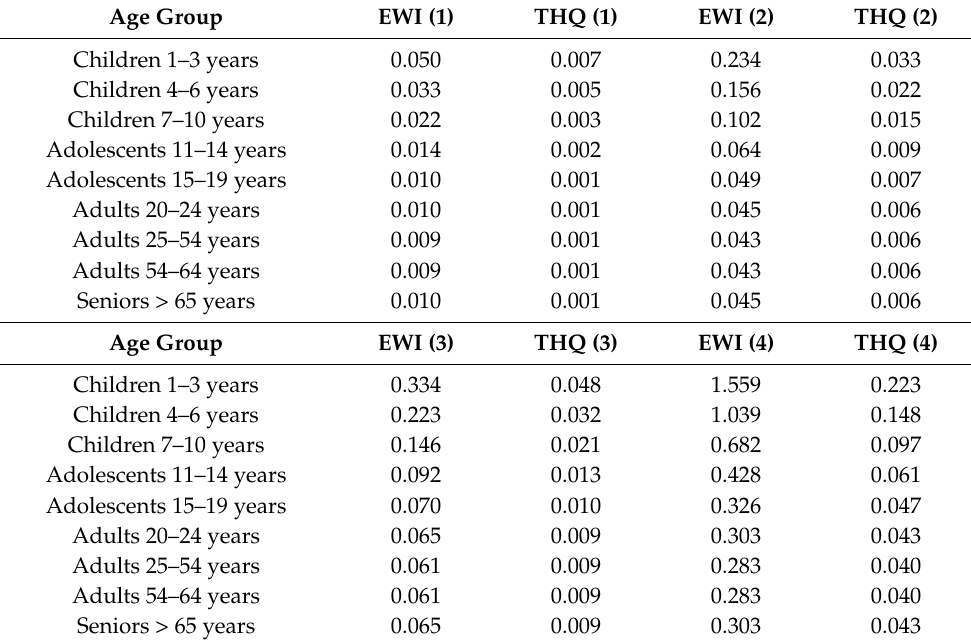
Table 2. Risk assessment for non-carcinogenic effects in humans by cadmium measured in the muscle of juvenile Solea senegalensis using Estimated Weekly Intakes (EWI) ( µ g kg − 1 body weight) and Target Hazard Quotients (THQ) for different age groups. Provisional Tolerable Weekly Intake (PTWI)